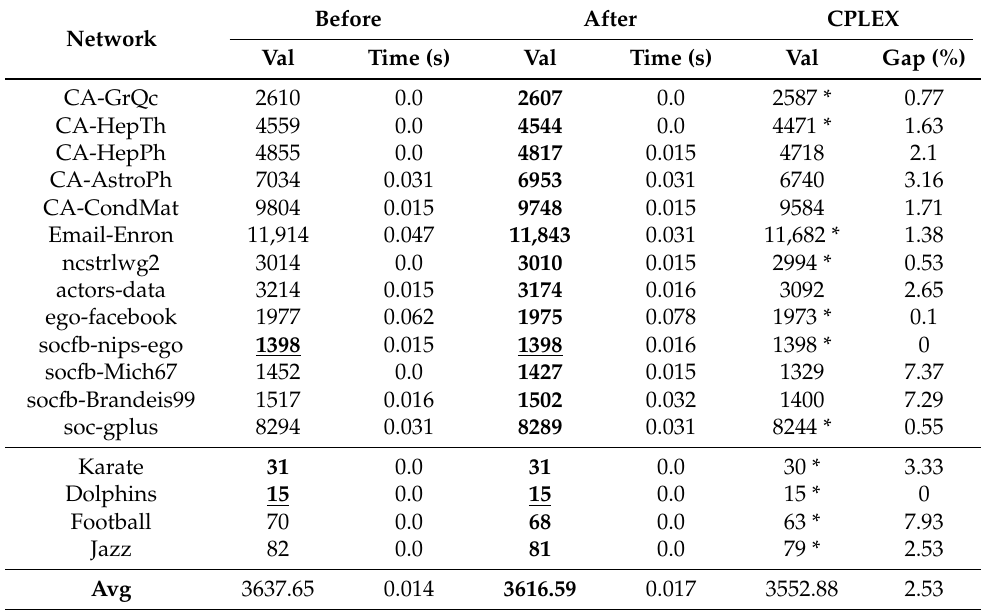
Table 6. Results before and after removing redundant vertices, and the comparison to